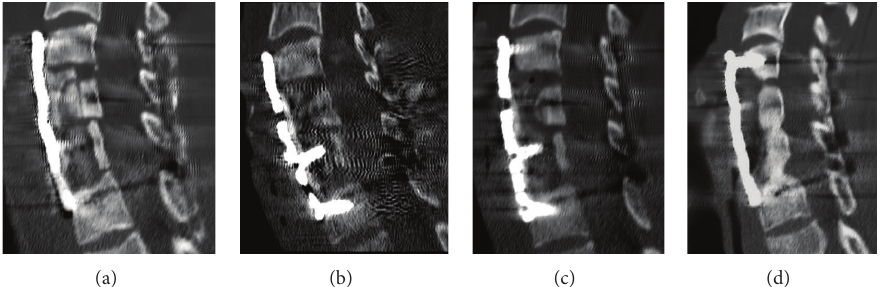
Figure 4: (a) One-month CT scans showing initial reabsorption of the tricortical bone graft with stability of the anterior plating. ((b) and (c)) Three- and 4-month CT scans showing extensive reabsorption of the bone graft with stability of the anterior plating. (d) One-year CT scan showing a fusion of the residual part of the bone graft and stability of the